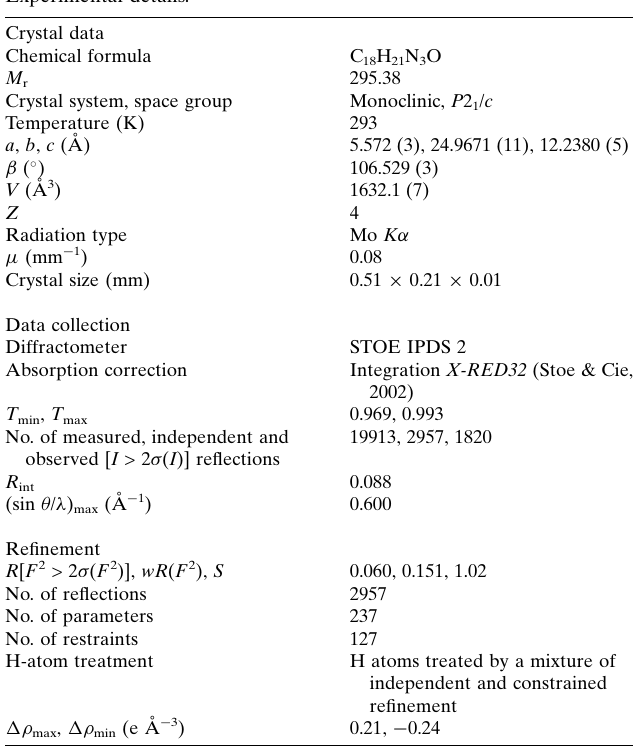
Table 2 Experimental details.